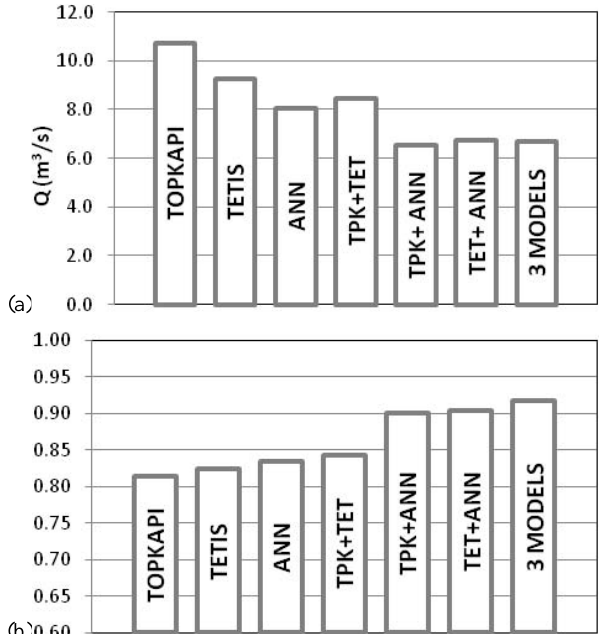
Fig. 12. Evaluation indexes for TOPKAPIi model (TPK), TETIS model (TET), ANN model and their combinations during the entire validation period of the MCP. (a) Standard Error; (b) Nash-Sutcliffe